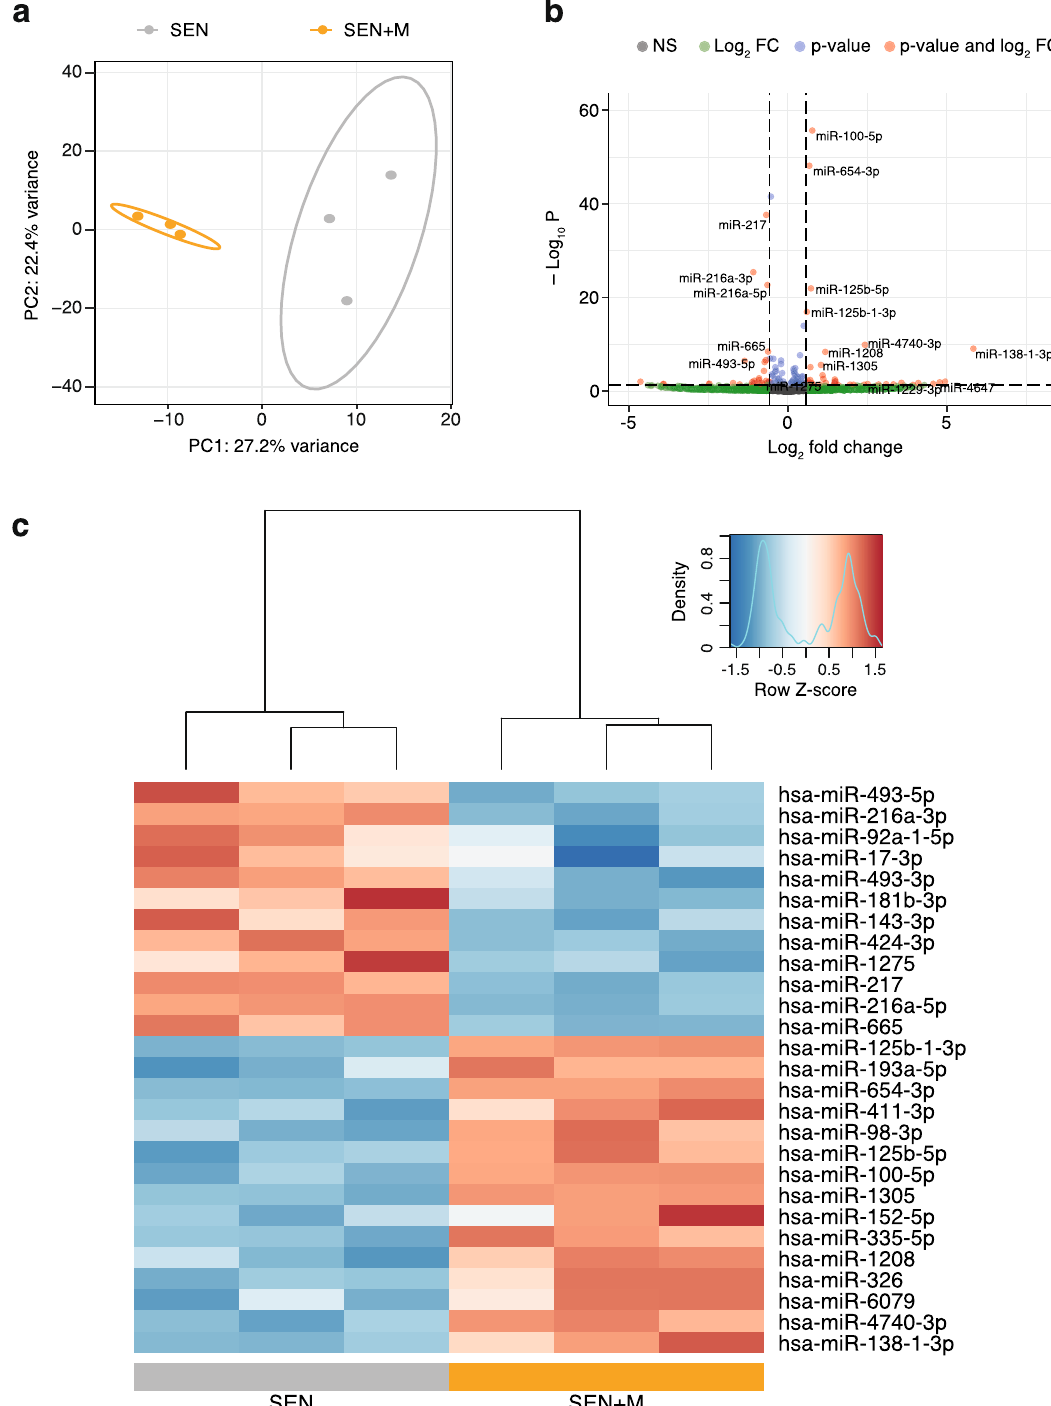
Figure 2. MiR-seq analysis of senescent HUVECs treated with metformin. ( a ) PCA plot of the first two principal components (PC1 and PC2) using transformed normalized miR-seq data. Circles represent 95% confidence intervals. ( b ) Volcano plot of log 2 fold-changes (FC, SEN + M compared to SEN) vs. -log 10 adjusted p-values using transformed normalized miR-seq data. MiRNAs with FC ≥ 1.5 (log2 FC ≥ 0.585) and FDR < 0.05 (− log10 p-value < 1.30) are highlighted in red. ( c ) Heatmap showing clustering of samples and miRNAs differentially expressed in SEN + M compared to SEN. Data is shown following Z-score transformation. Red color indicates Z-scores > 0 (above mean), blue colors indicate Z-scores < 0 (below mean). MiRNAs are ranked according to the lowest log 2